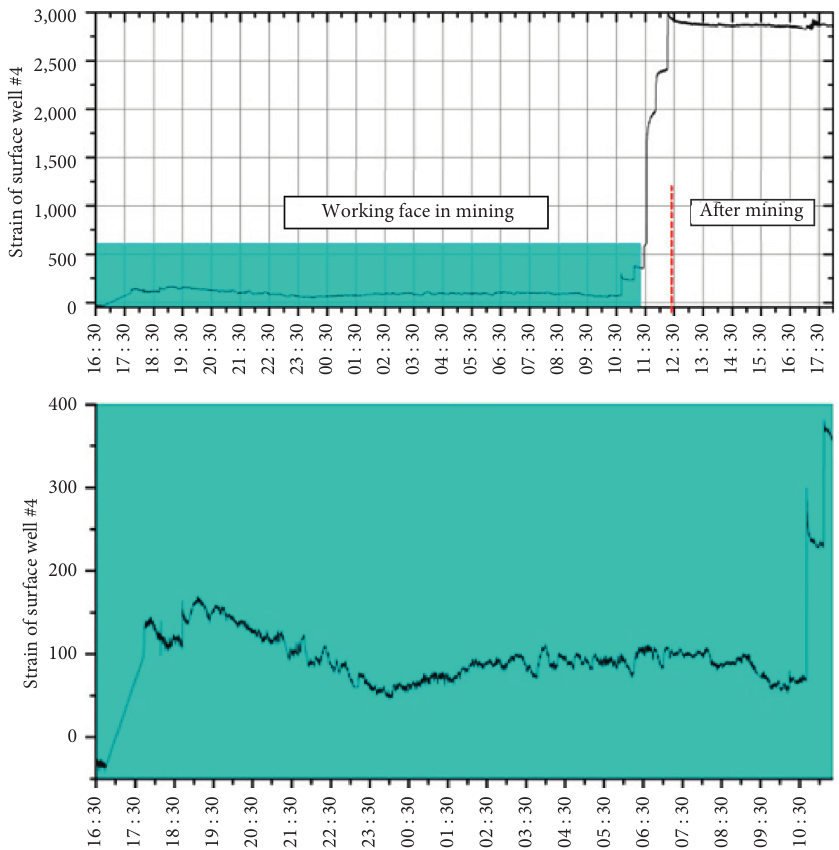
Figure 16: Strain of surface well #4 at 30.45m (measuring point 4-1) above the coal